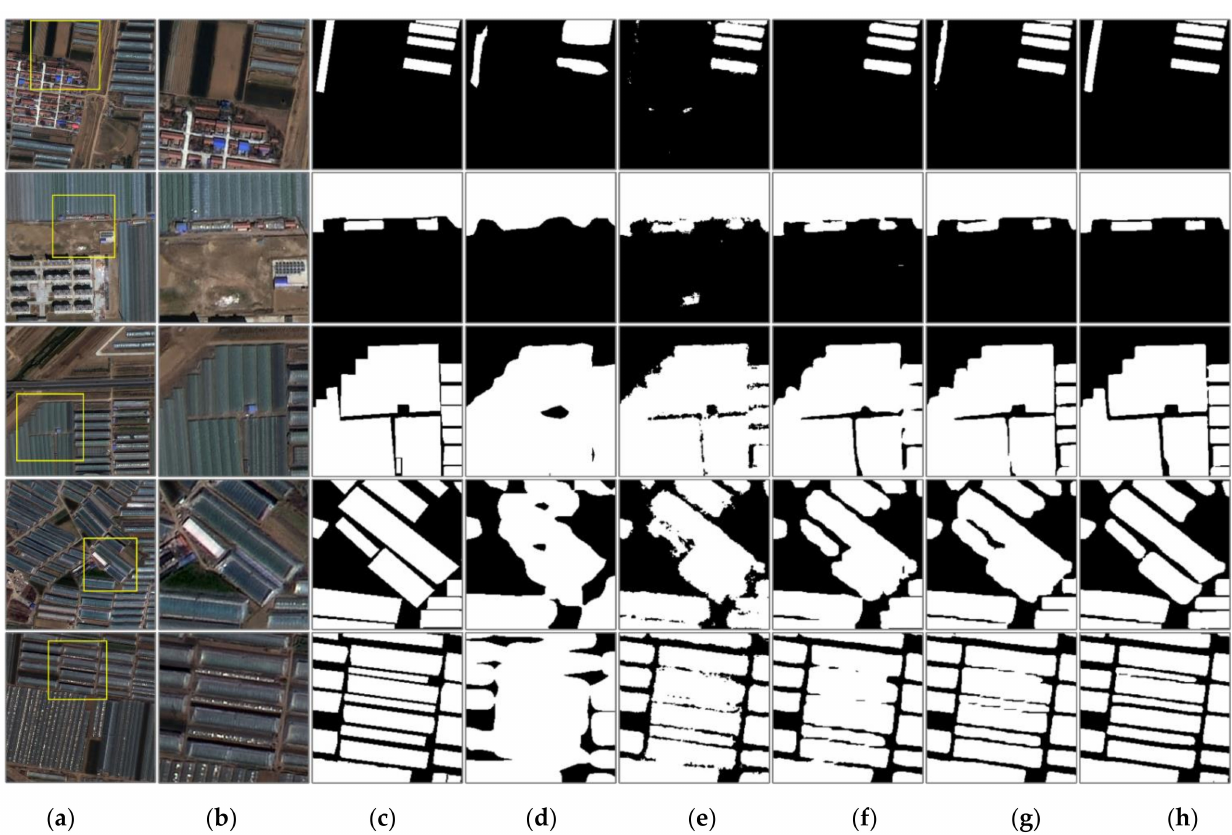
Figure 12. Results extracted by part of the SOTA methods in a closer perspective. Images and results presented in column ( b – h ) correspond to the selected regions circled by the yellow rectangle in ( a ). ( a ) Original image. ( b ) Image of typical area. ( c ) Ground truth; ( d ) FCN; ( e ) SegNet; ( f ) PSPNet; ( g ) HRNetV2; ( h )